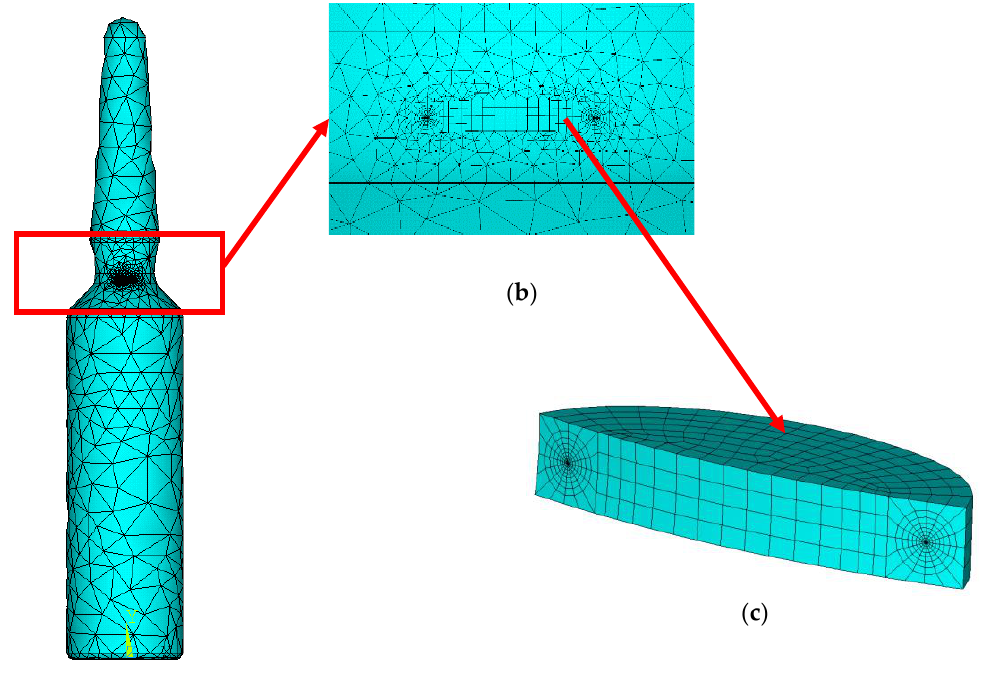
Figure 3. Mesh model of the FEM for semi-elliptical cracks on the neck of an ampoule bottle. ( a ) Global mesh model. ( b ) Local mesh amplification of cracks. ( c ) Cracked grid cells.